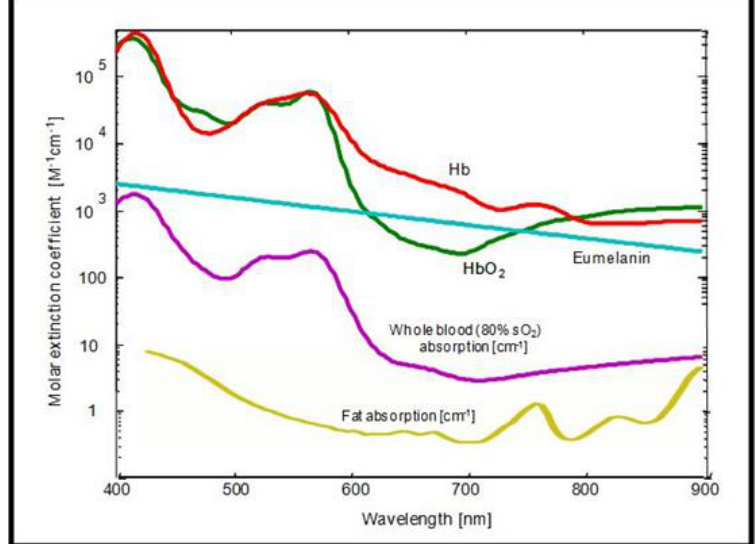
Figure 10. Spectra of dominant intrinsic absorbers in biological tissue in the visible and near-infrared range. Chromophores can be distinguished by their different spectral dependence of the absorption coefficient on the wavelength (data taken from